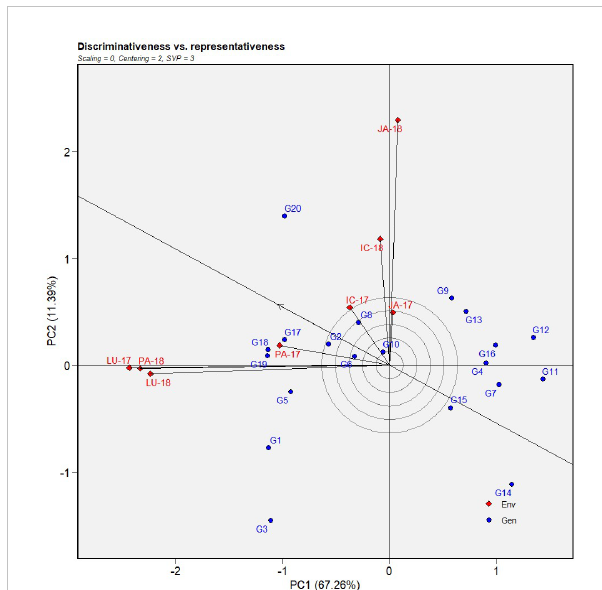
FIGURE 3 Discriminativeness vs. representativeness view of GGE biplot of IABN against AB severity across four locations during 2 years. The data were centered through environments (centering = 2) without scaling (scaling = 0). Locations are denoted as IC- (ICRISAT), JA- (Jammu), LU- (Ludhiana), and PA- (Palampur). Years are denoted as -17 (year 2017/2018) and -18 (year 2018/2019). IABN, International Ascochyta Blight Nursery; AB, Ascochyta blight.